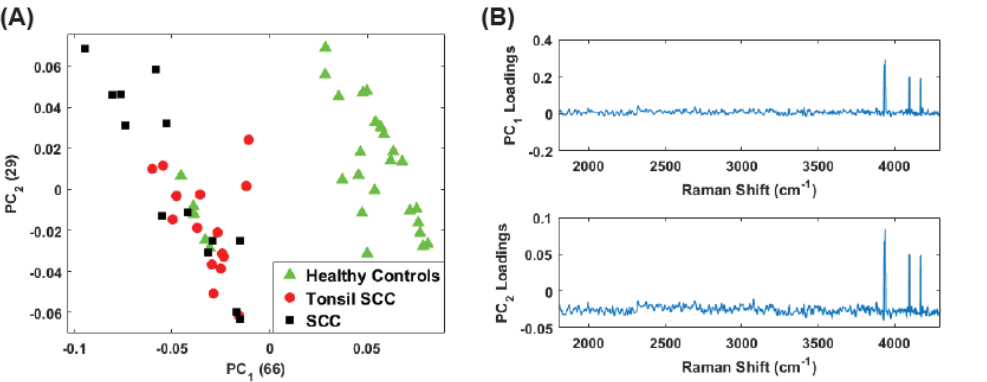
Figure 11. ( A ) Plot of the first two PC scores for all (stained and unstained) the tissue samples. The analysis was performed in the Raman shift region from 1800 cm − 1 –4300 cm − 1 and continues to show good separation between the healthy and diseased tissue classes despite the inclusion of the stained tissue samples. The numbers in parentheses represent the information content associated with each principal component. ( B ) Corresponding loadings plots for the PCs shown in ( A